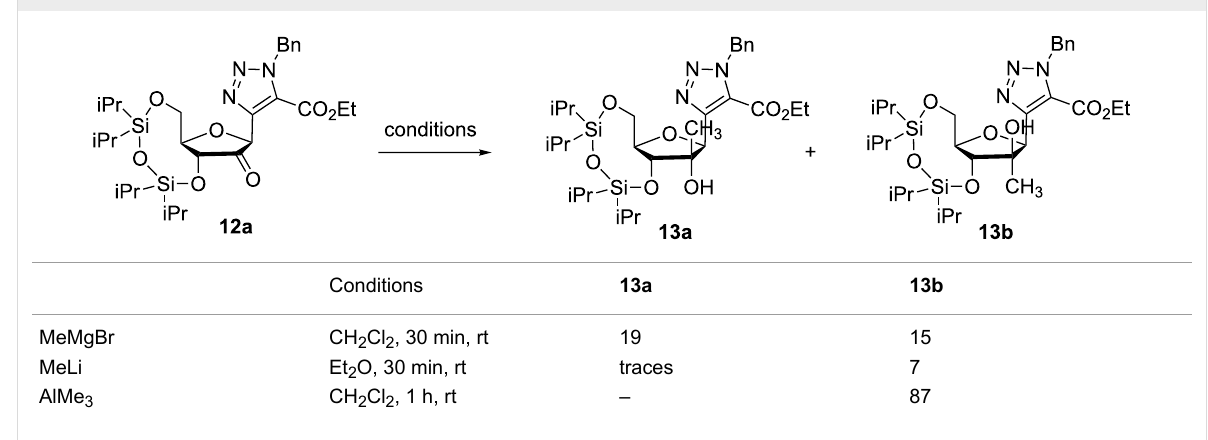
Table 1: Methylation of ketone 12 .